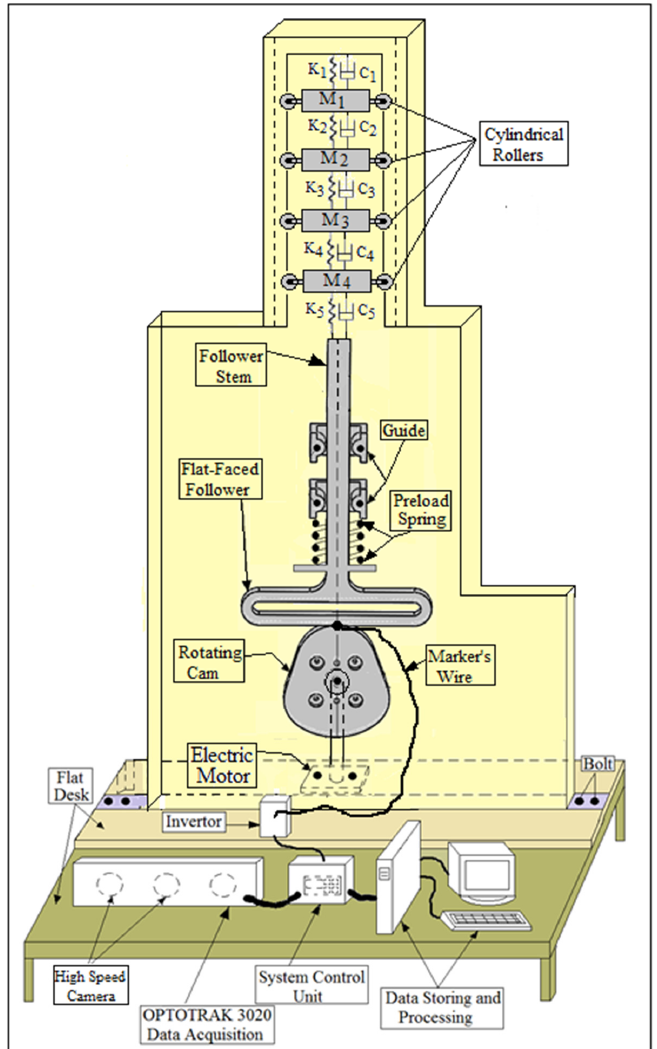
Figure 1. Experiment setup of cam–follower mechanism.